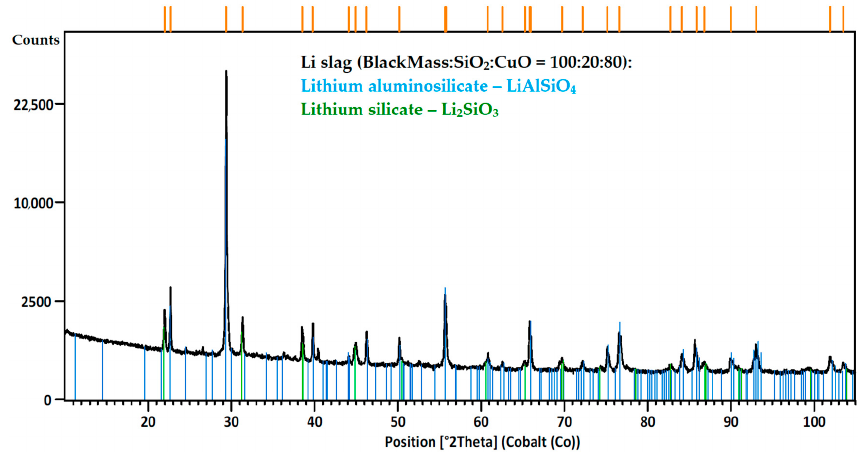
Figure 3. XRD analysis of the Li slag.